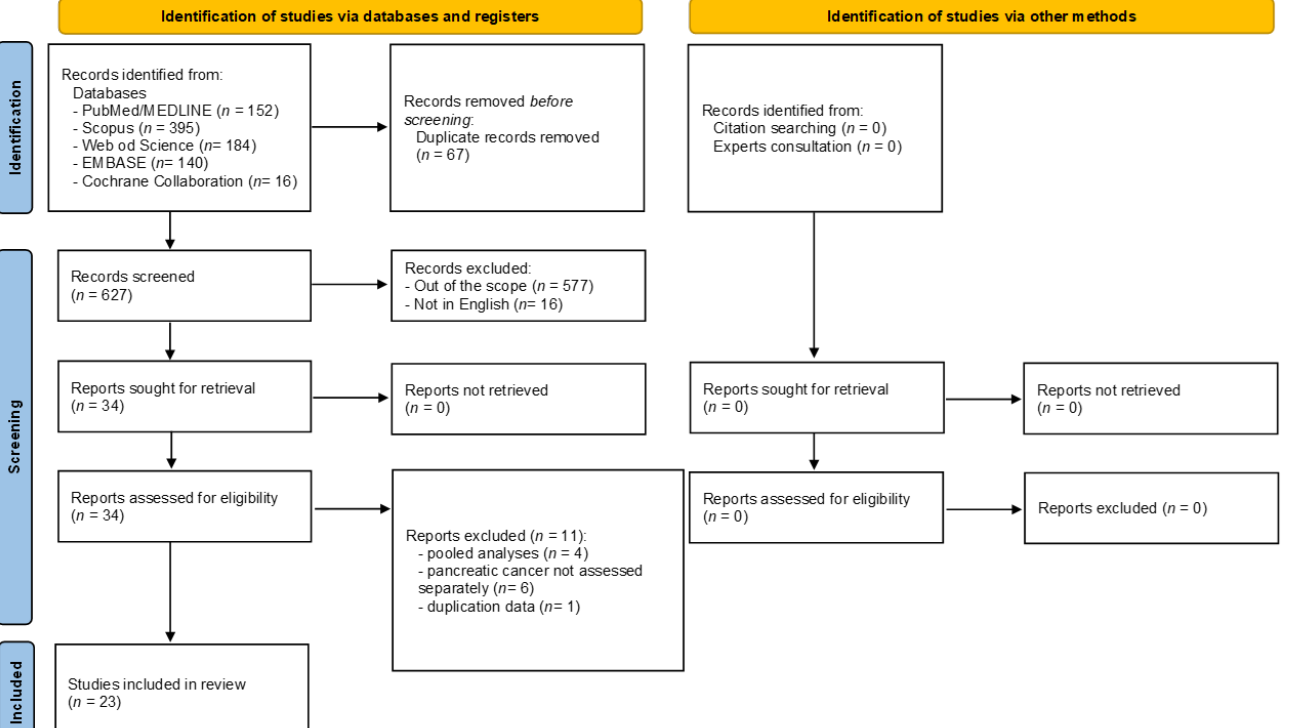
Figure 1. Flow diagram of the selection process.